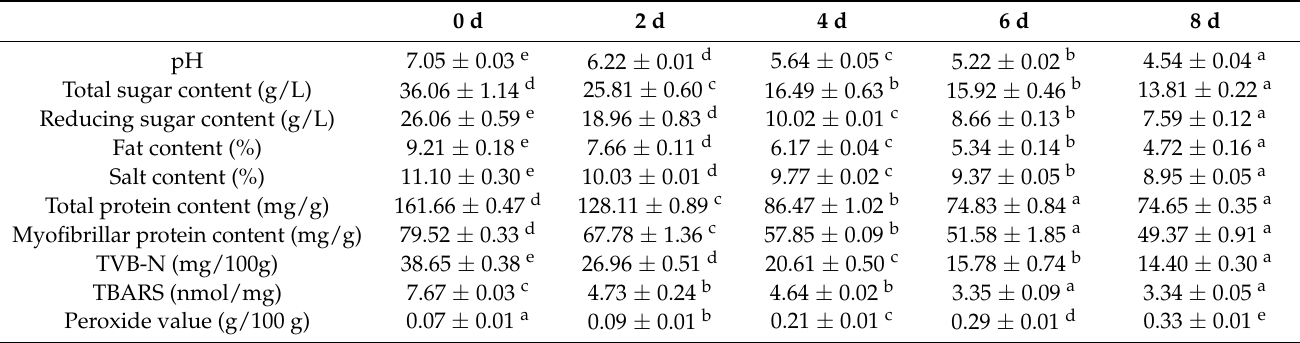
Table 2. Physicochemical properties changes in vinasse hairtail during